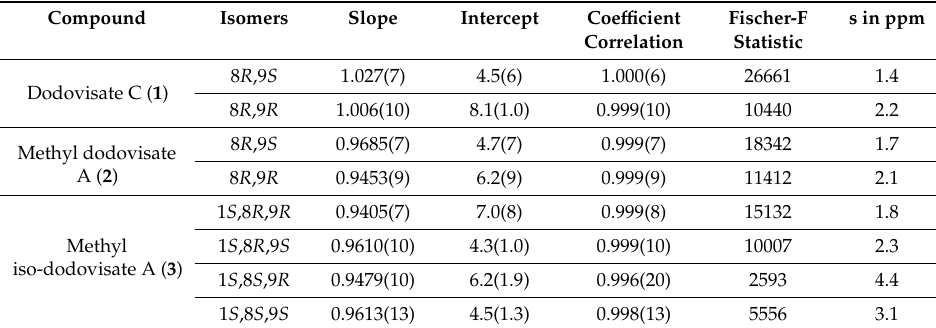
Table 7. Showing linear regressions of theoretical chemical shifts versus experimental values for isomers of dodovisate C ( 1 ), methyl dodovisate A ( 2 ) and methyl iso-dodovisate A ( 3 ) standard errors on the slope, the intercept and the correlation coe ffi cient, Fischer-F statistic factor and standard error of the fit in ppm.